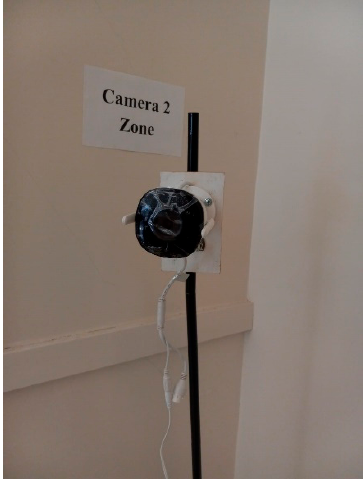
Figure 6. Placement of one of the Imou Smart Cameras.